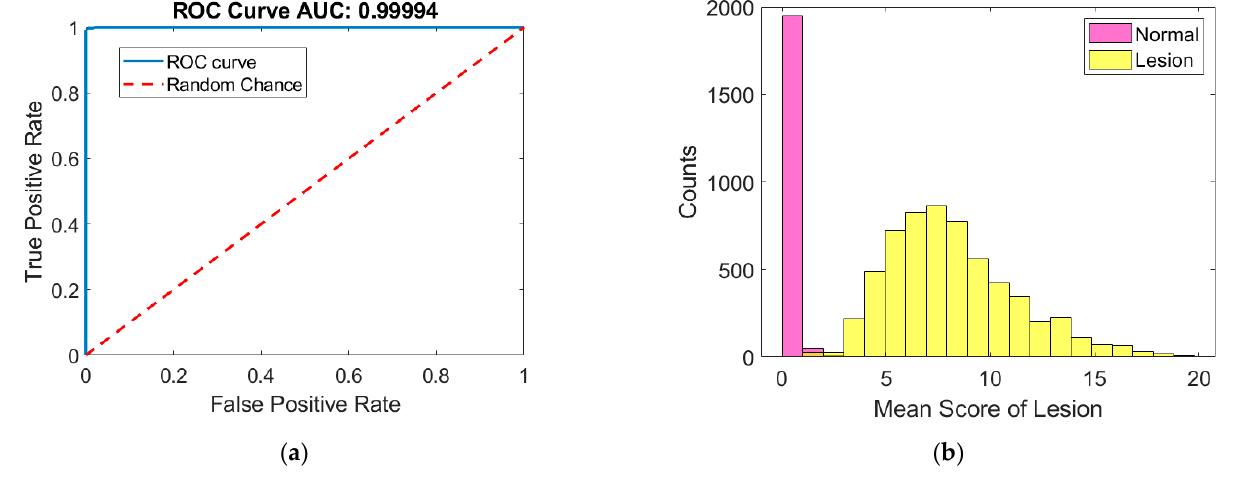
Figure 3. Classification results. ( a ) ROC-AUC curve; ( b ) mean lesion scores.